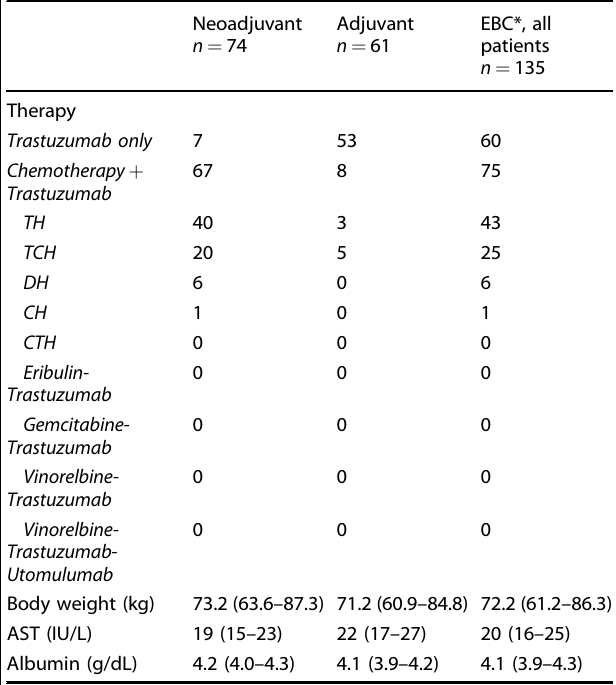
Table 1. Patient clinical and laboratory characteristics (median and interquartile